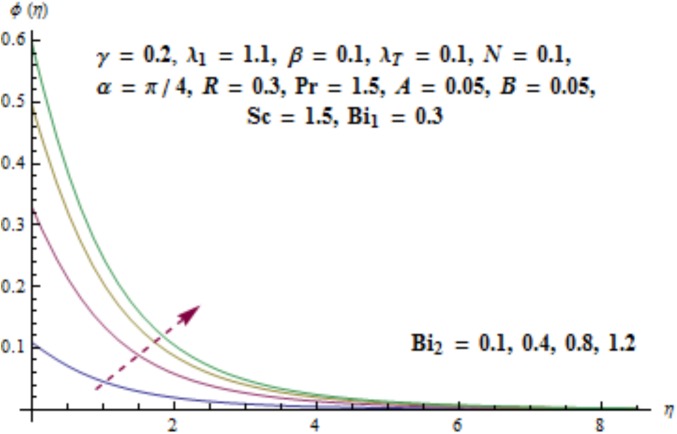
Behavior of Bi2 on ϕ(η).